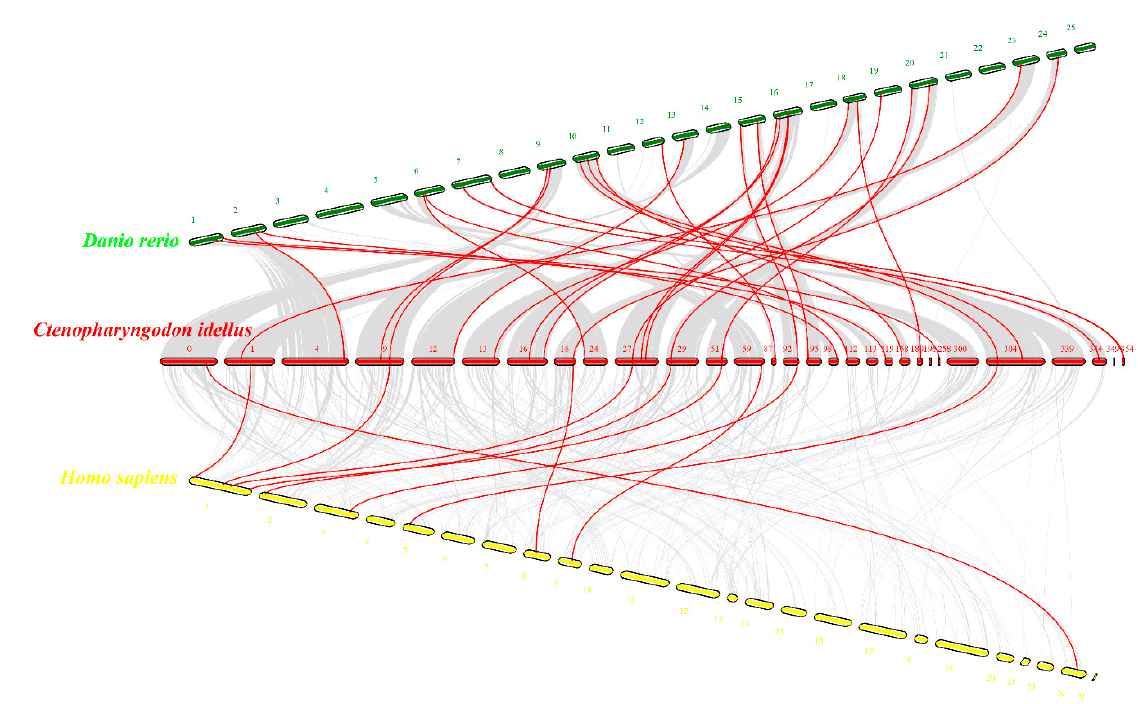
Figure 3. Gene collinearity analysis of Ci TRIMs with those from the zebrafish and human genomes. Red, green, and yellow short sticks represent scaffolds from the grass carp genome, zebrafish genome and human genome, respectively. The red lines indicate TRIM gene pairs between species.